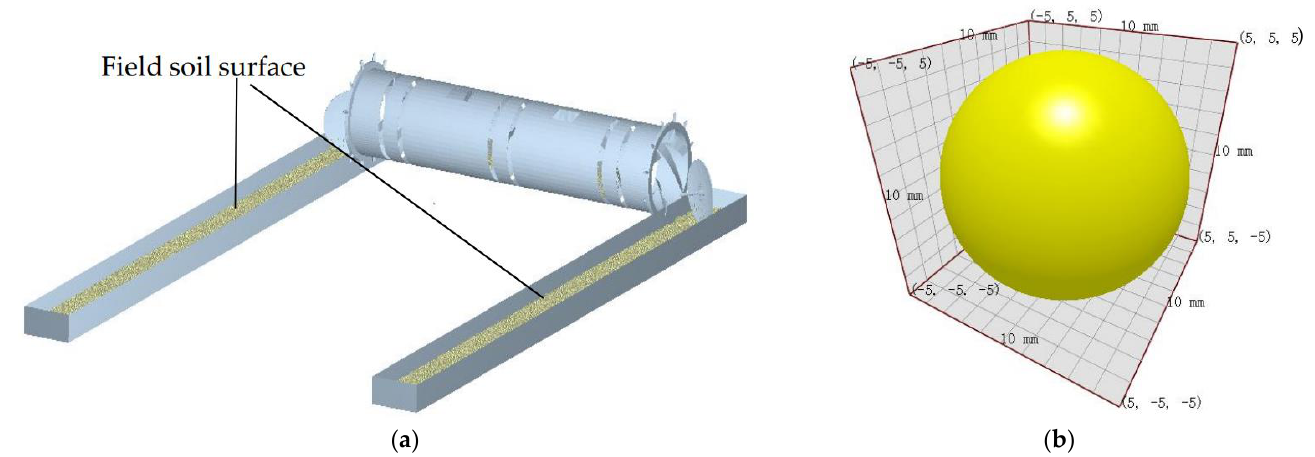
Figure 5. ( a ) Simulation model. ( b ) Particle model.